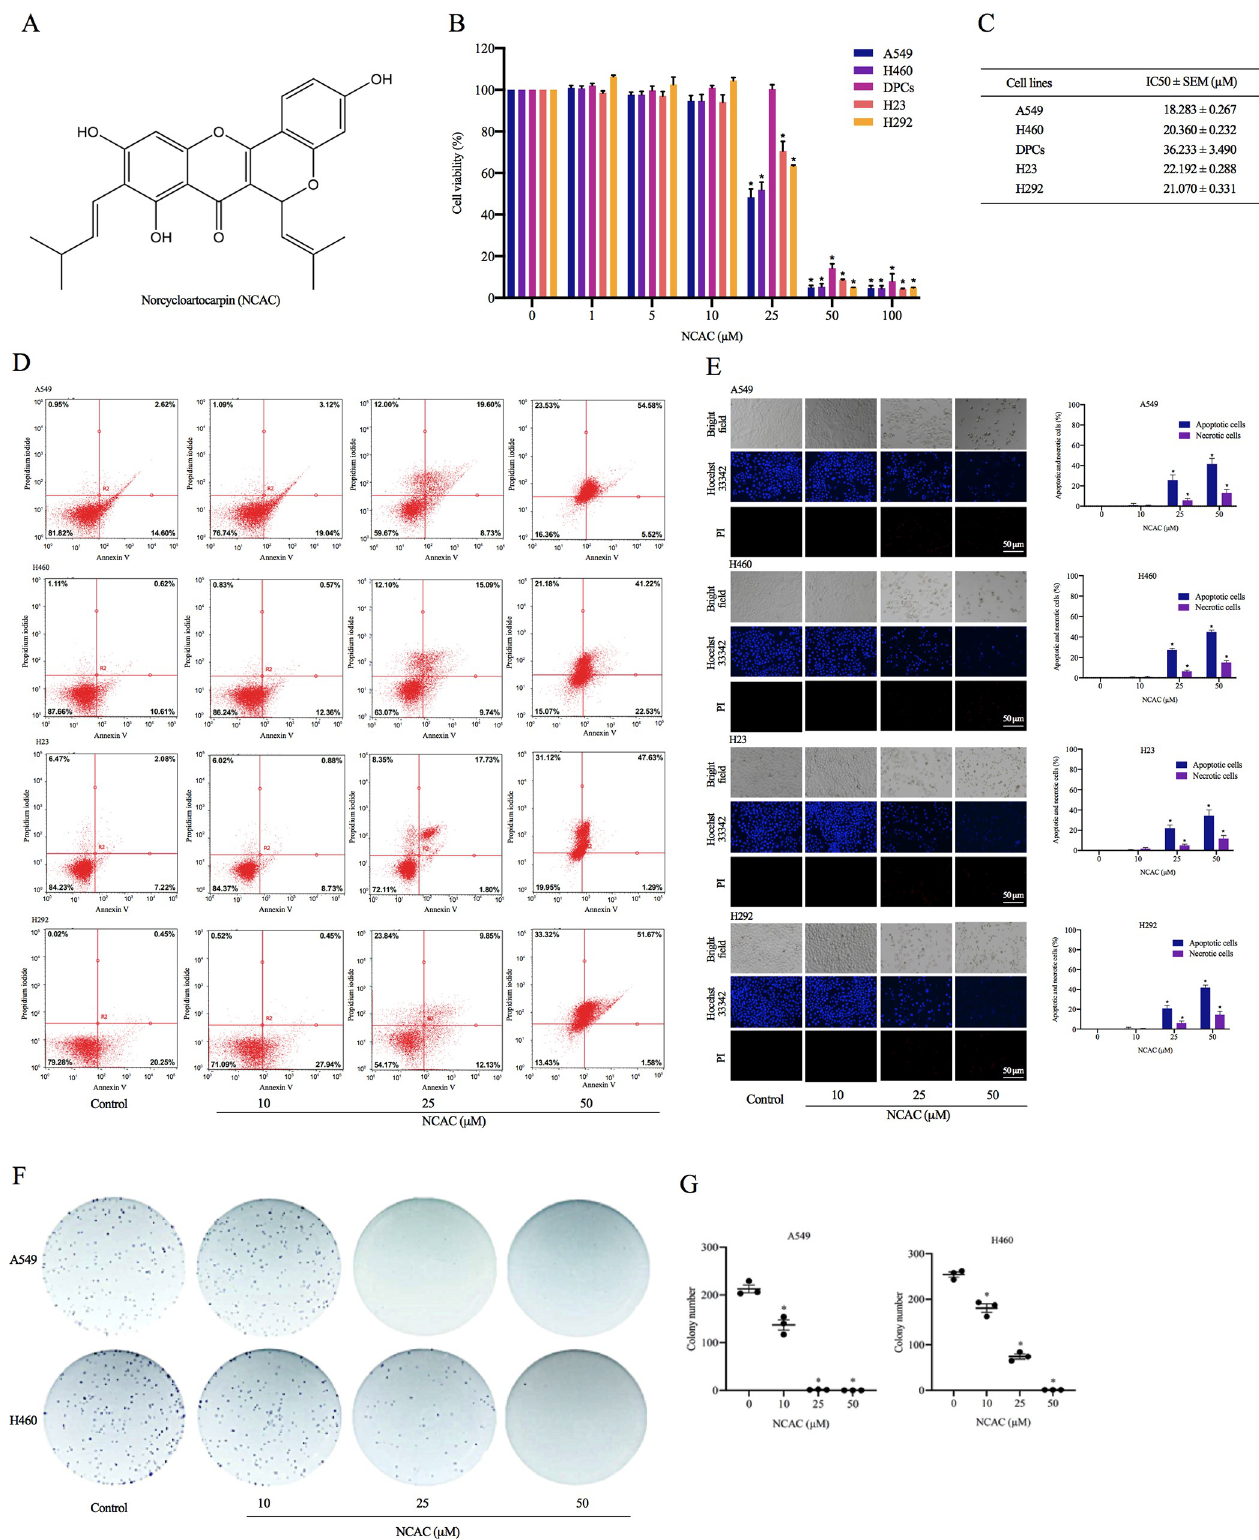
Fig 1. The selective anticancer activity of ( A ) norcycloartocarpin (NCAC), a flavonoid extracted from A . gomezianus was indicated by ( B ) the significant reduction of %cell viability in human lung cancer A549, H460, H23, and H292 cells while no alteration found in human dermal papilla DPCs cells cultured